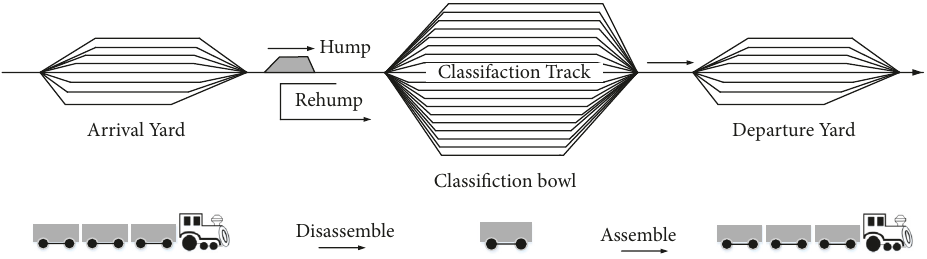
Figure 1: A schematic layout of a typical hump